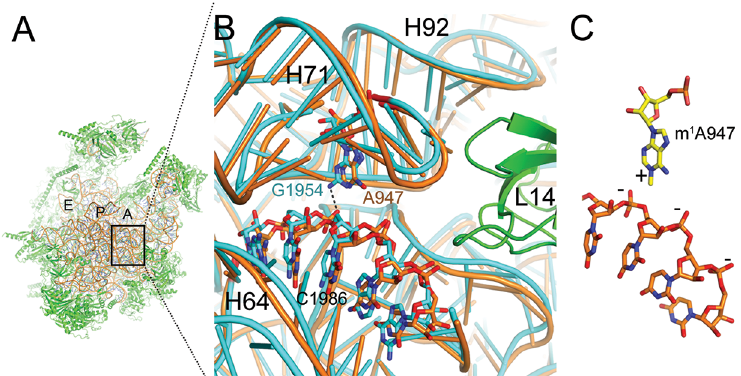
Fig 4. High structural conservation between S . scrofa mitoribosome and E . coli ribosome at position 947. ( A ) The structure of the porcine mitoribosomal large subunit (PDB accession code 4v1a and 4v19) shown from the subunit interface side. The ribosomal RNA is shown in brown and the ribosomal proteins in green. The ribosomal tRNA A-, P-, and E-binding sites are indicated. ( B ) Sticks-and-ribbon representation of interaction between helices H71 and H64 in S . scrofa (brown) mitoribosome or E . coli (turquoise) ribosome (PDB accession code 4ybb). The hydrogen bond that is likely disrupted by an adenine in position 947 is represented as a dashed line. ( C ) The positively charged m 1 A947 stabilizes the structure by interacting with the negatively charged H64 backbone. Numbers refer to the positions of E . coli ribosomal